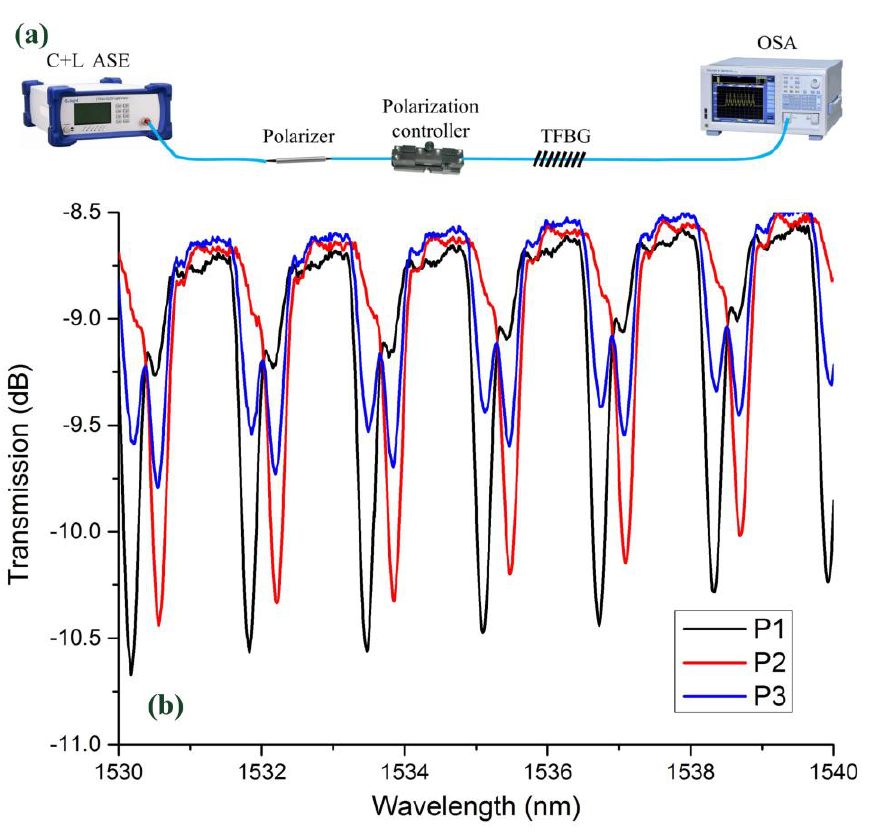
Figure 6. ( a ) Schematic of polarization-dependent spectrum measurement system. ( b ) Spectra of 18°TFBG under different polarization states.